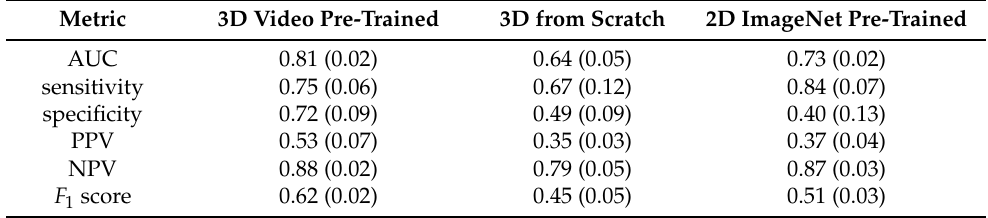
Table 2. Test results for the three different models. Scores represent mean (std) values for the ten times each model was